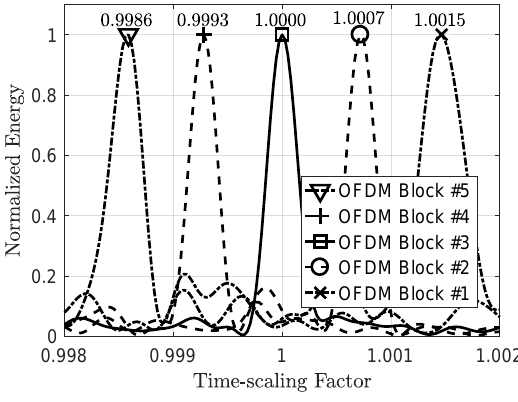
Figure 6. An example of linear search for time-scaling factor estimation in a packet of five OFDM blocks. The points for which the energies are maximized show the optimum time-scaling